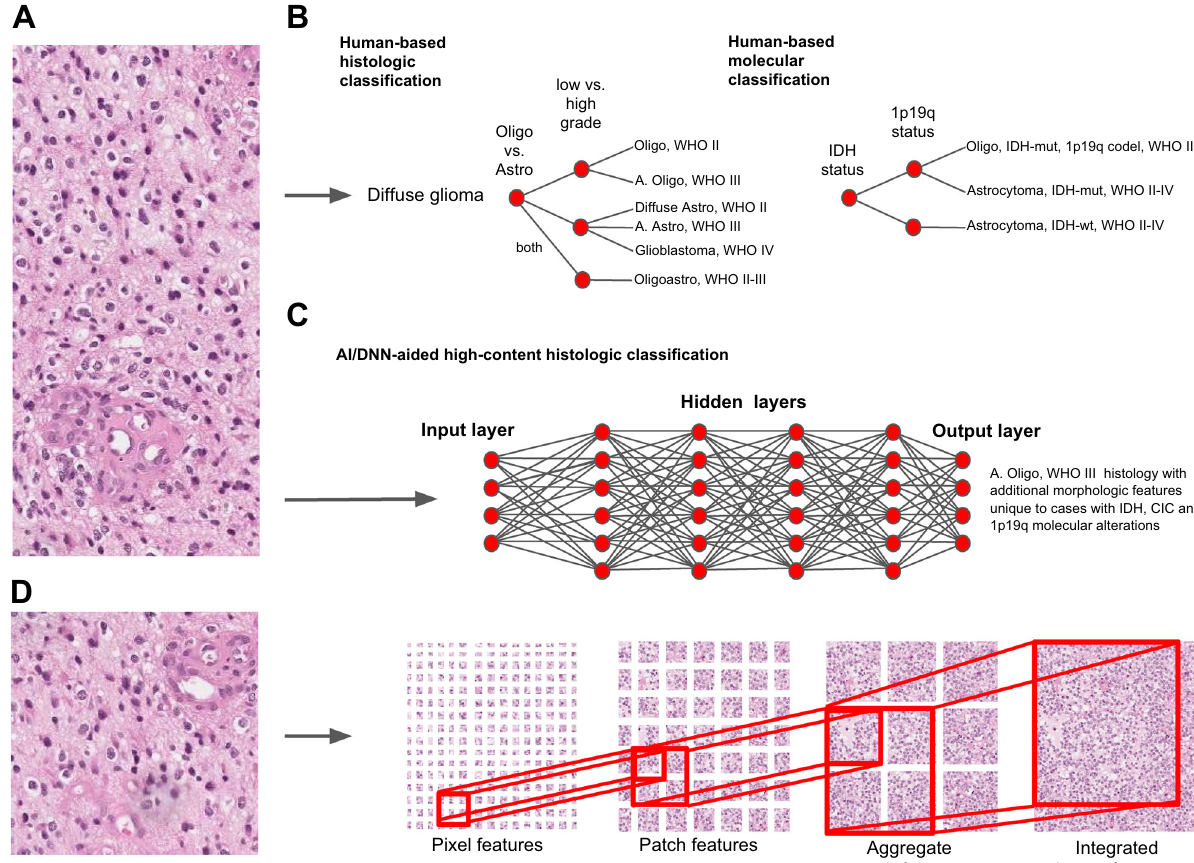
Fig. 1 Diagnostic decision-making algorithms in pathology. a Digital image of a H&E stained slide showing classic histologic features of an anaplastic oligodendroglioma, WHO grade III. b Unaided human-based classi fi cation algorithms utilize simple and highly reproducible decision tree-based approaches. Even with new more objective molecular tools, the need for highly uniform and reproducible diagnostic reporting limits the number of alterations that can be extracted from data-rich molecular data sets. c , d Machine learning-based approaches may allow for multi-parametric feature extraction and aggregation that permit even subtle but reproducible groups of features to be integrated into classi fi cation schemes. DNNs may thus tolerate reliable extraction of a larger number of unappreciated features that can be correlated with speci fi c entities, outcomes, and molecular changes. IDH isocitrate dehydrogenase, IDH-mut IDH-mutated, IDH-wt IDH-wildtype, CIC capicua, Oligo oligodendroglioma, Astro astrocytoma, Oligoastro oligoastrocytoma, WHO World Health Organization malignancy grading